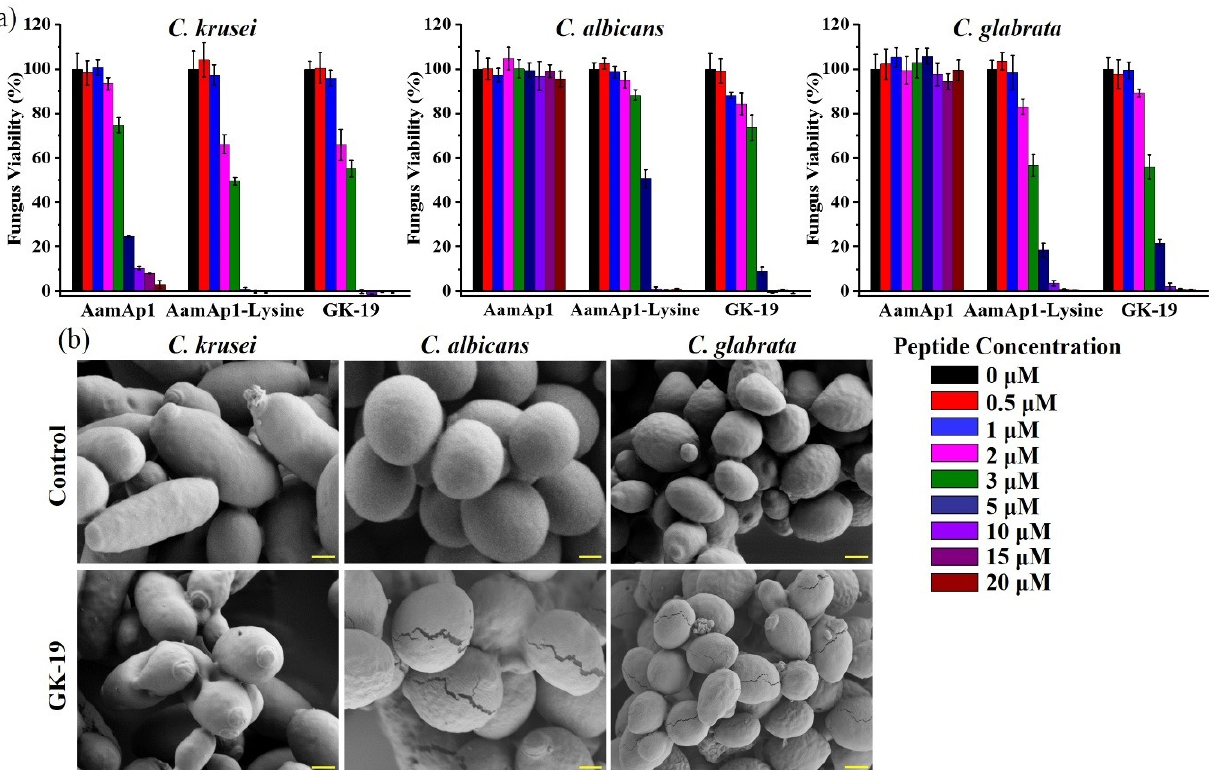
Figure 2. Antifungal activity of AamAP1, AamAP1-Lys and GK-19. ( a ) Dose-dependent survival of C. krusei, C. albicans and C. glabrata treated with different antimicrobial peptides for 12 h. Fungi (1 × 10 6 CFU/mL) were incubated with the peptides at concentrations varying from 0 to 20 μ M. (n = 5) ( b ) SEM images of different fungi after 2 h of incubation with GK-19 at a concentration of 50 μ M. Scale bar: 1 μ m.